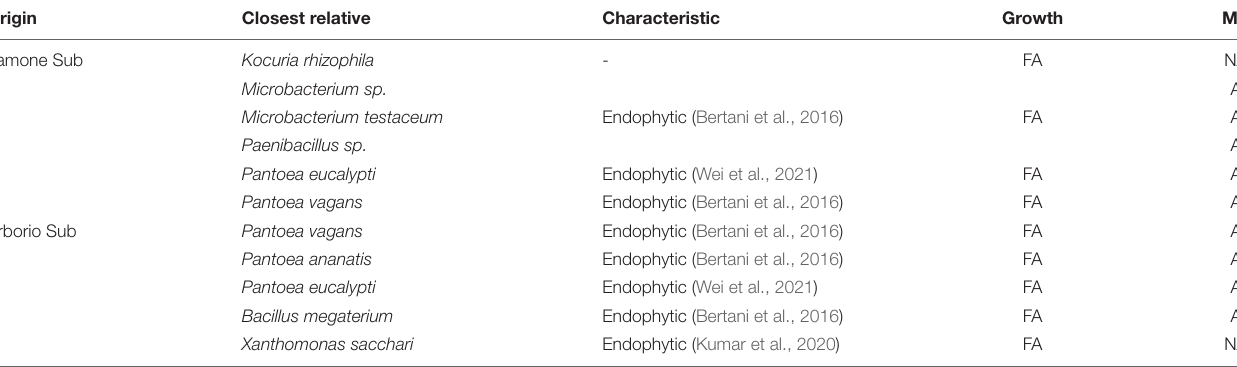
TABLE 2 | Putative bacterial endophytes isolated from Arborio and Lamone rice varieties at day 4 under dark submergence (Sub), and isolated under